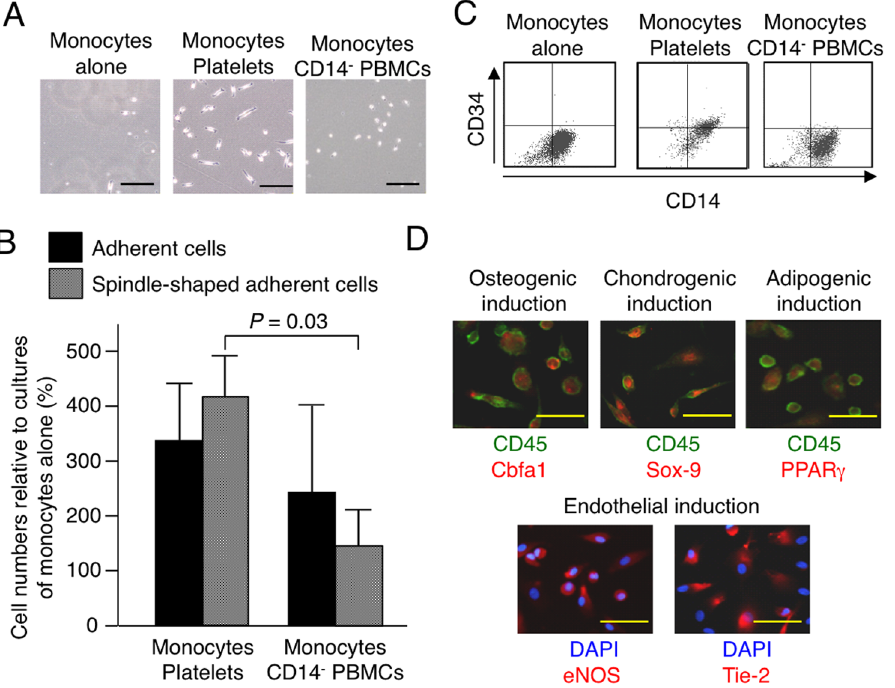
Figure 1. Platelets are required for the generation of MOMCs. CD14 + monocytes were cultured on fibronectin with platelets or platelet- depleted CD14 2 PBMCs, or on fibronectin alone. ( A ) Morphology of adherent cells on culture day 7. Bars: 200 m m. ( B ) The total number of cells and the number of spindle-shaped adherent cells generated are expressed in proportion (%) to those generated by monocyte culture alone. The results shown are the mean and SD of three independent experiments. ( C ) Cell-surface CD14 and CD34 expression on the cultured adherent cells, as analyzed by flow cytometry. ( D ) The multidifferentiation potential of adherent cells obtained by culturing monocytes and platelets. Cells treated for osteogenic, chondrogenic, adipogenic, and endothelial induction for 1 week were analyzed by immunohistochemical staining for Cbfa1, Sox-9, or PPAR c (red) in combination with CD45 (green), or for eNOS or Tie-2 (red) in combination with DAPI (blue), and were observed under a fluorescence microscope. Representative results of three independent experiments are shown. Bars: 50 m